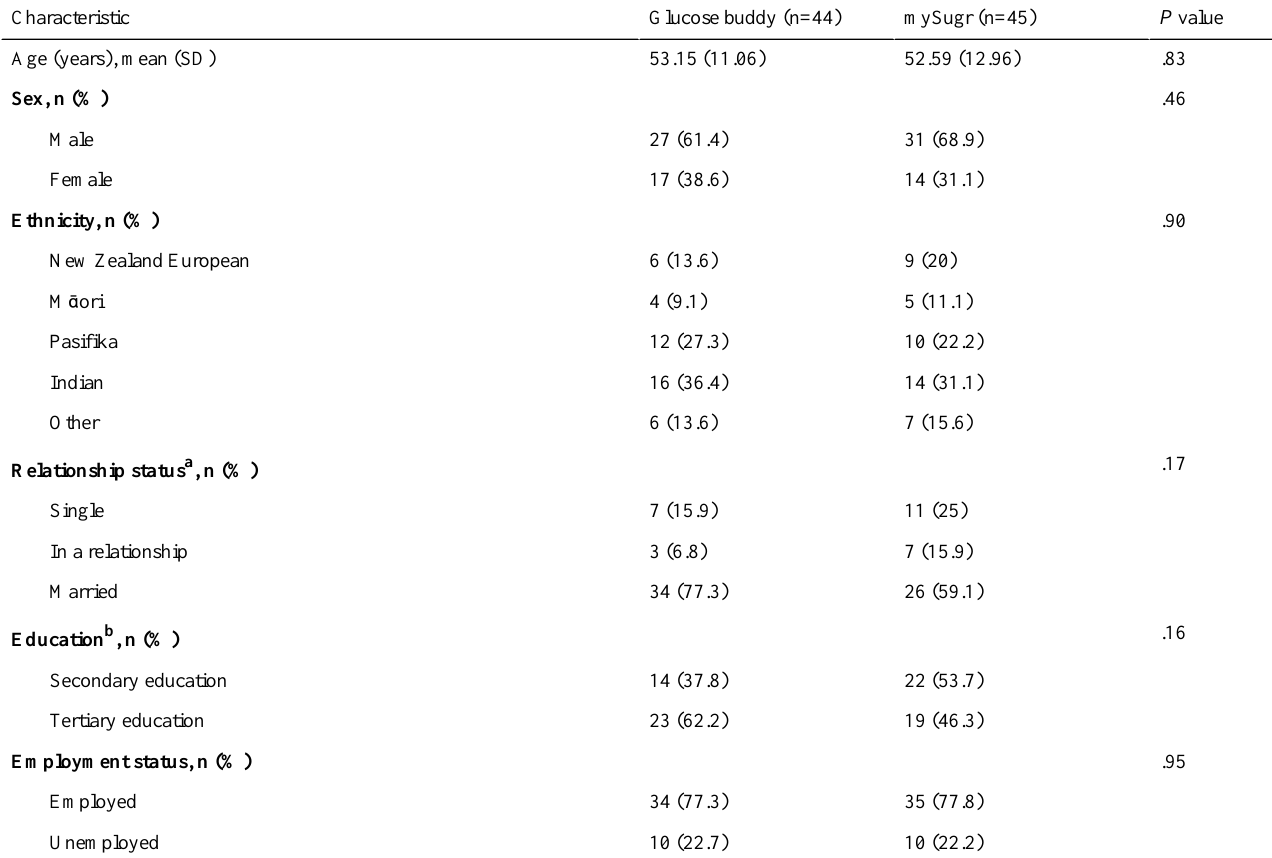
Table 1. Baseline characteristics of participants